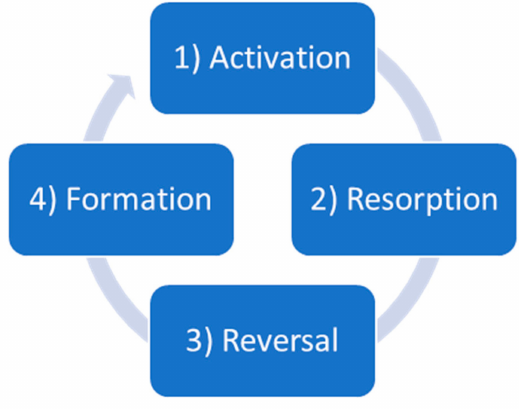
Figure 1. Sequential remodelling in cancellous bone.